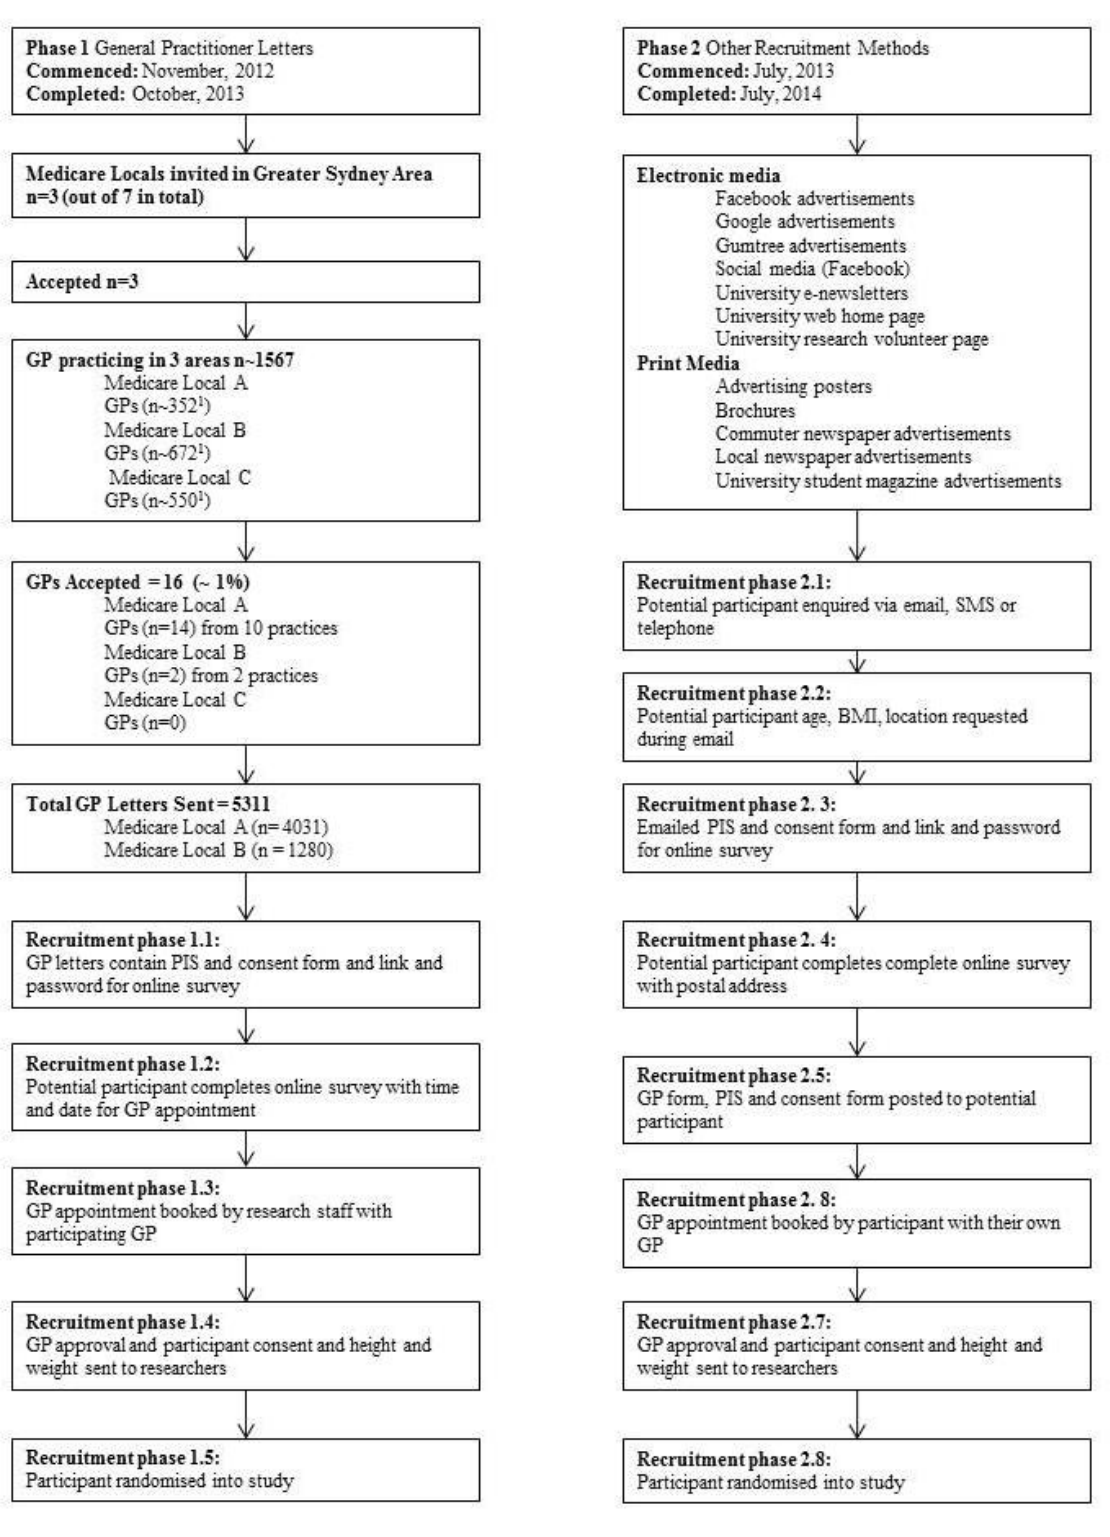
Figure 1. Flow diagram for recruitment phases of the TXT2BFiT study. The number of GPs in each area is approximate. Information obtained from Medicare Local website